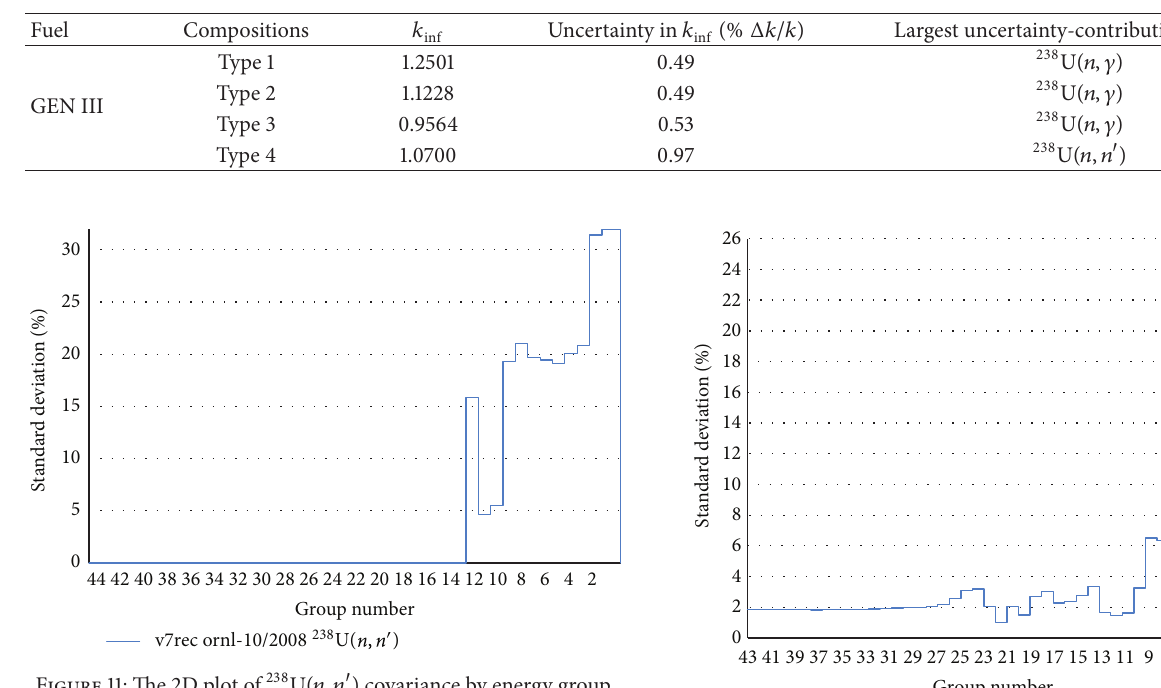
Figure 11: The 2D plot of 238 U( 𝑛, 𝑛 󸀠 ) covariance by energy group.